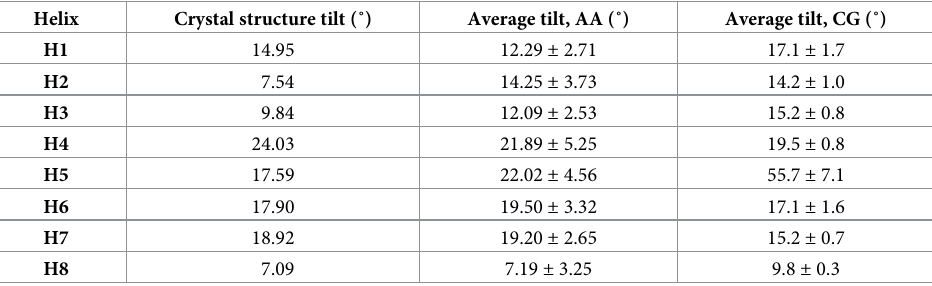
Table 3. Tilt angle, using Bendix, for μ OR embedded in POPC membrane. Helix